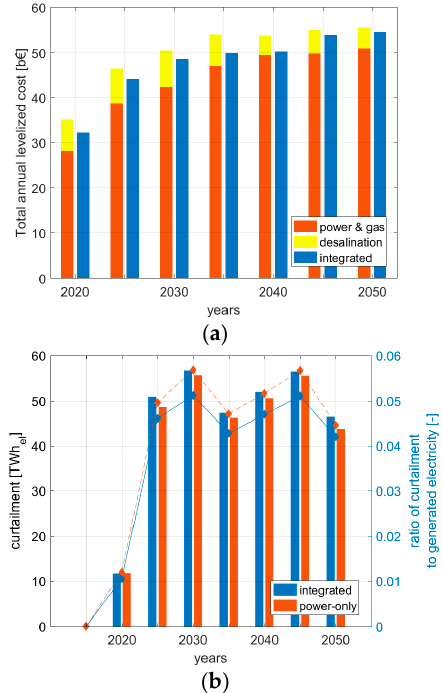
Figure 16. Comparison of total annual levelised cost ( a ) and the curtailed electricity ( b ) for the integrated and non-integrated